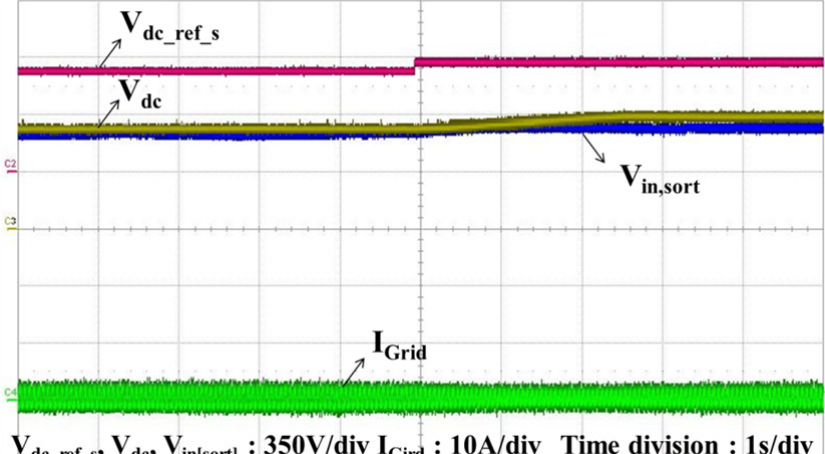
Figure 19. Experimental results for the DC-link voltage, V Figure 11 when the temperatures of PV1 is decreased.